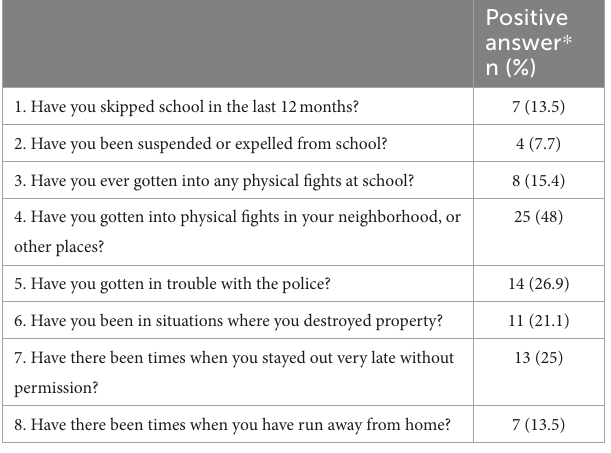
TABLE 4 Descriptive statistics of the behavioral problems outcome among 52 Syrian adolescent refugees displaced to South Beirut.